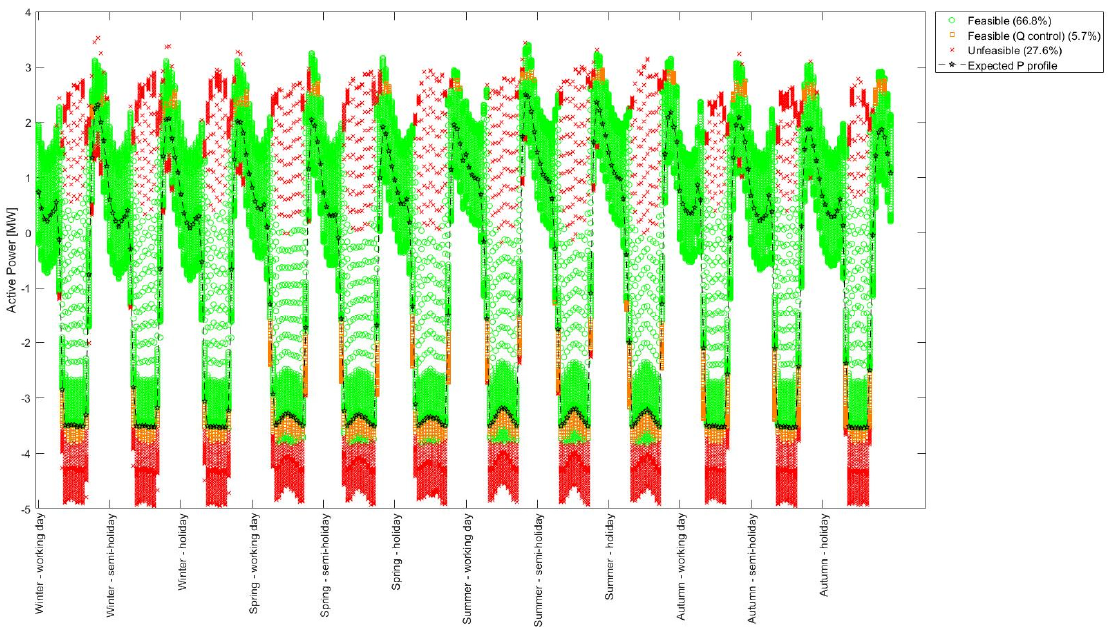
Figure 7. Potential P profile during all representative days, feeder R1—case B (“DG + end-users”).